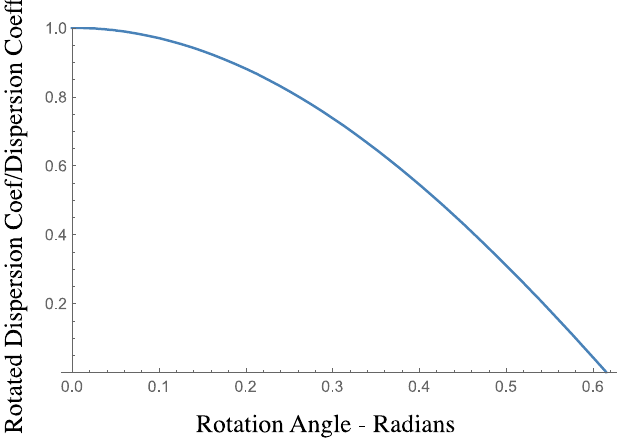
Figure 9. The dispersion coe ffi cient µ ( α ) of the rotated 1 + 1 NLS solution is reduced with respect to Figure 9. The dispersion coefficient  (  ) of the rotated 1+1 NLS solution is reduced with respect to Figure 9. The dispersion coefficient  (  ) of the rotated 1+1 NLS solution is reduced with respect to Figure 9. The dispersion coefficient  (  ) of the rotated 1+1 NLS solution is reduced with respect to that for the unrotated 1 + 1 NLS equation as the rotation angle varies between 0 and 35.2644 degrees. that for the unrotated 1+1 NLS equation as the rotation angle varies between 0 and 35.2644 degrees. that for the unrotated 1+1 NLS equation as the rotation angle varies between 0 and 35.2644 degrees. that for the unrotated 1+1 NLS equation as the rotation angle varies between 0 and 35.2644 degrees.